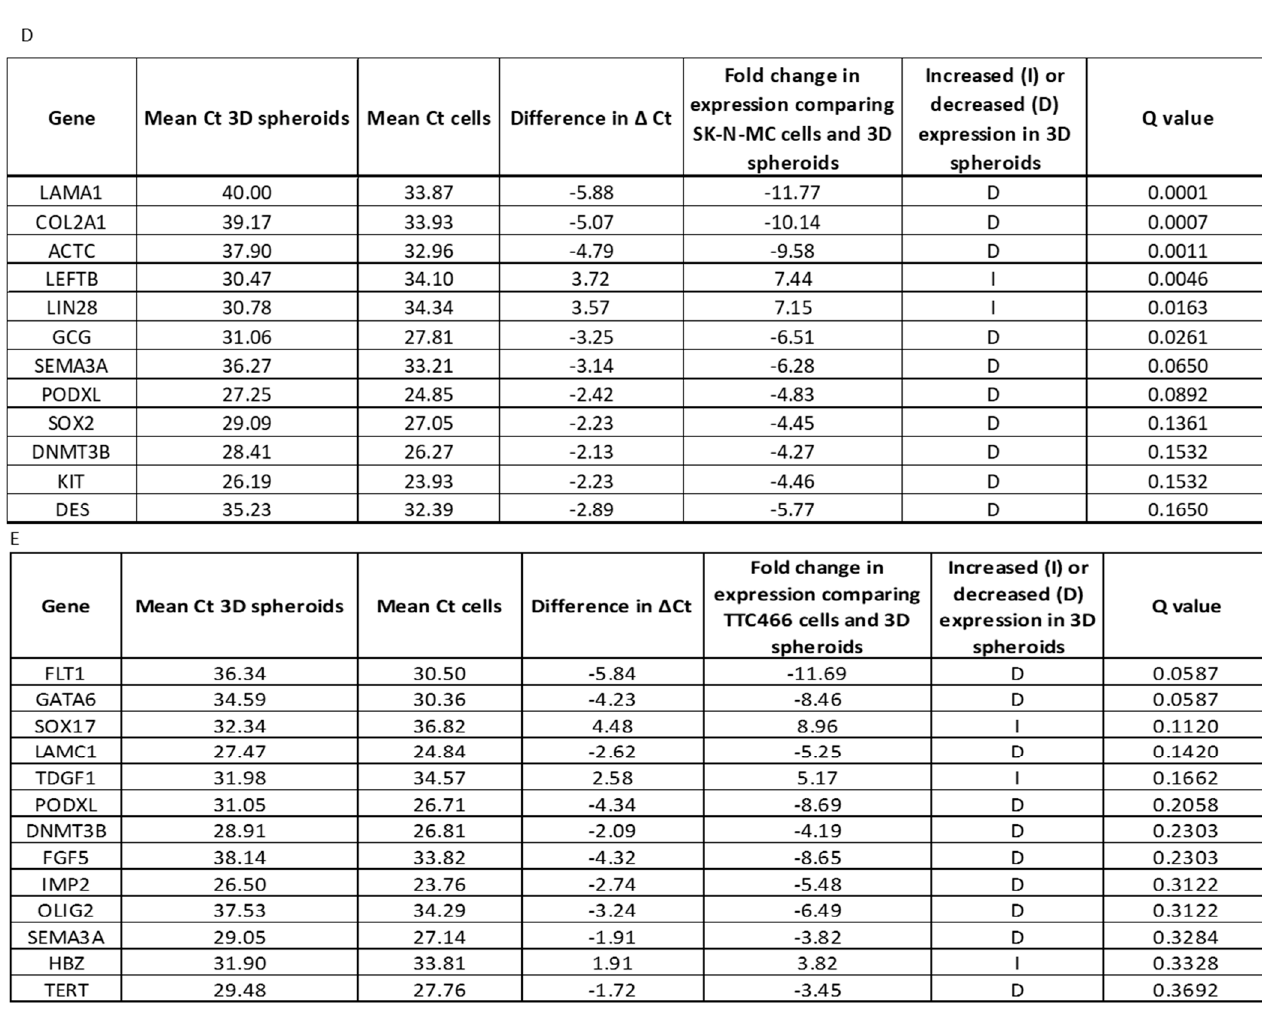
Figure 3. Expression of pluripotency genes in SK-N-MC and TTC 466 cells in 2D and 3D spheroid cultures. ( A ) Summary of strategy to identify shared markers of stemness and MDR in ES cell lines. RNA (1 µg) from ( B ) SK-N-MC and ( C ) TTC 466 cells in 2D and 3D cultures were analysed by